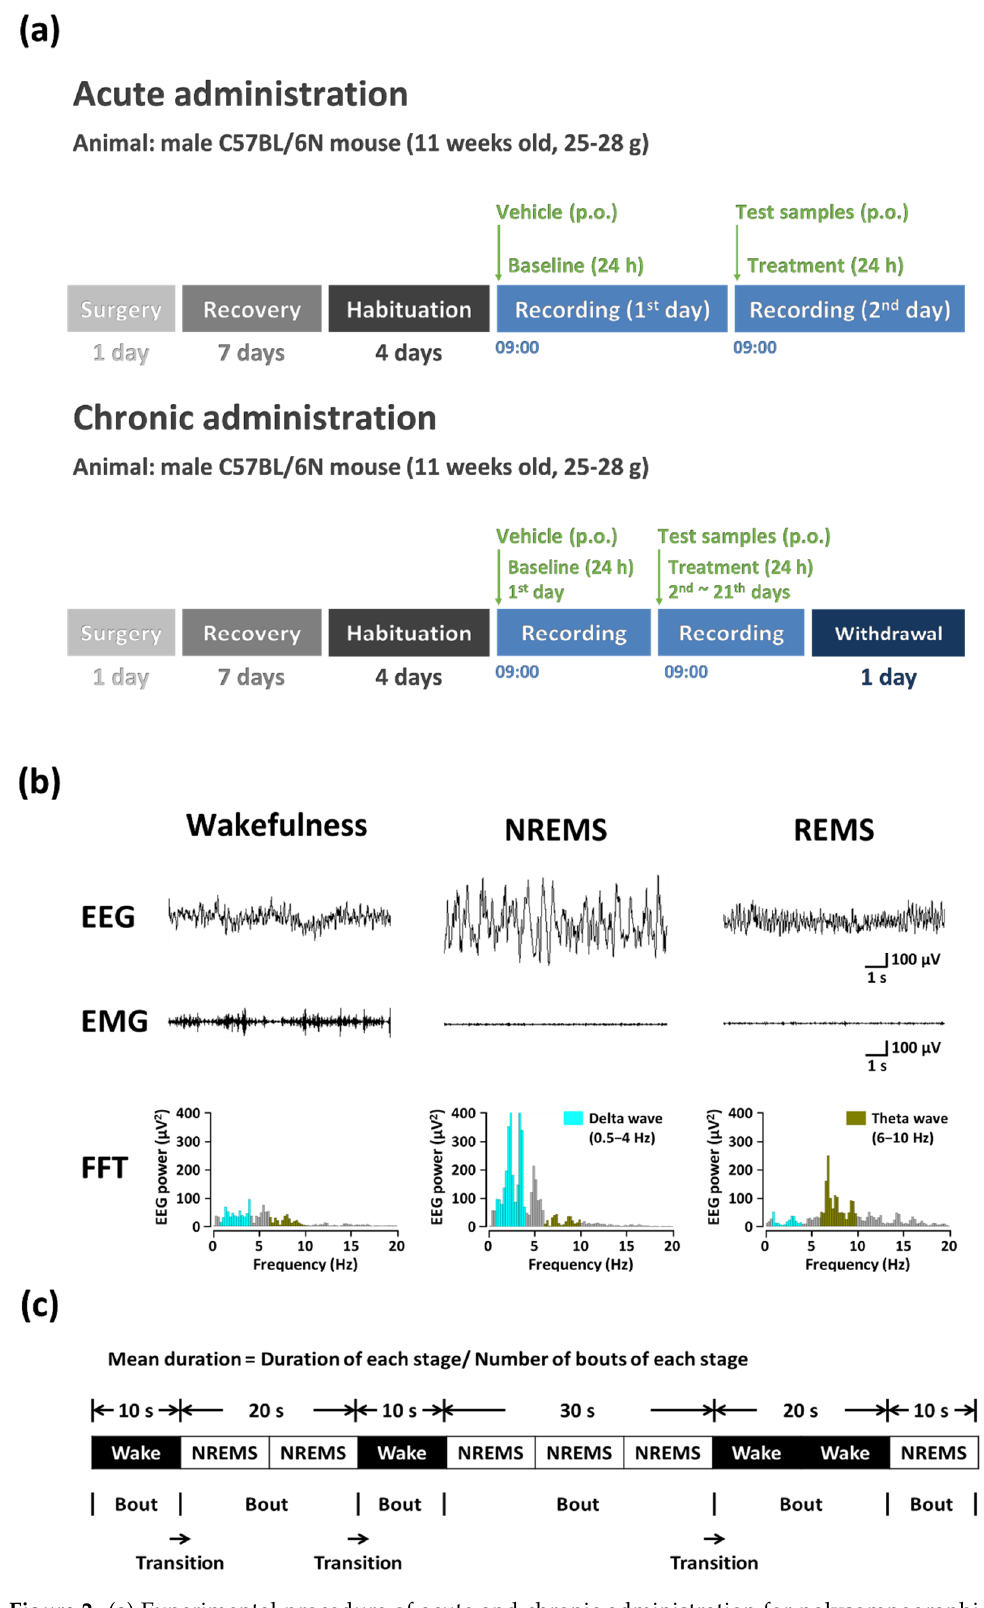
Figure 2. ( a ) Experimental procedure of acute and chronic administration for polysomnographic recordings. ( b ) Typical EEG, EMG, and FFT spectra in C57BL/6N mice. ( c ) Definition of sleep– wake episodes. p.o., per os injection. NREMS, non-REMS; REMS, rapid eye movement sleep; EEG, electroencephalogram; EMG, electromyogram; FFT, fast Fourier